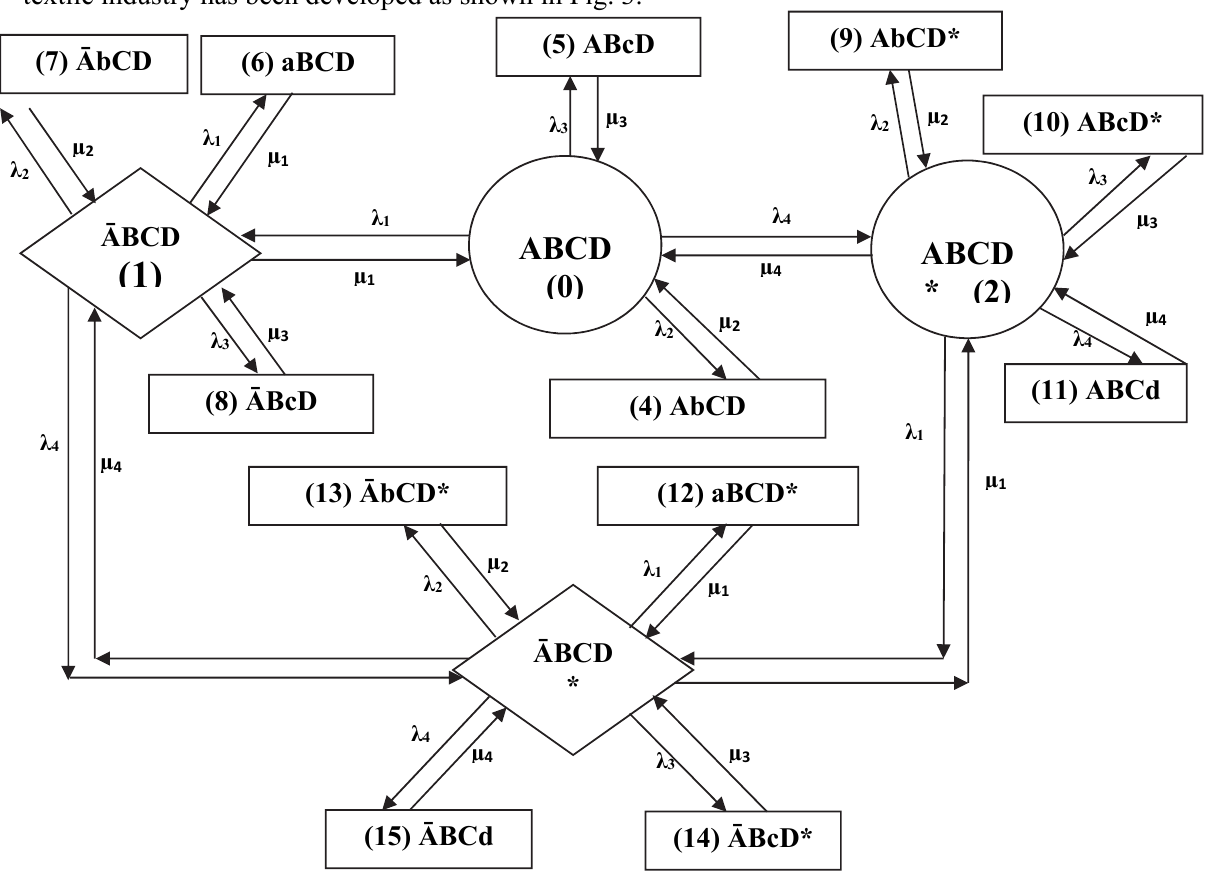
Fig. 3. Transition Diagram of Fabric Finishing System of a Textile